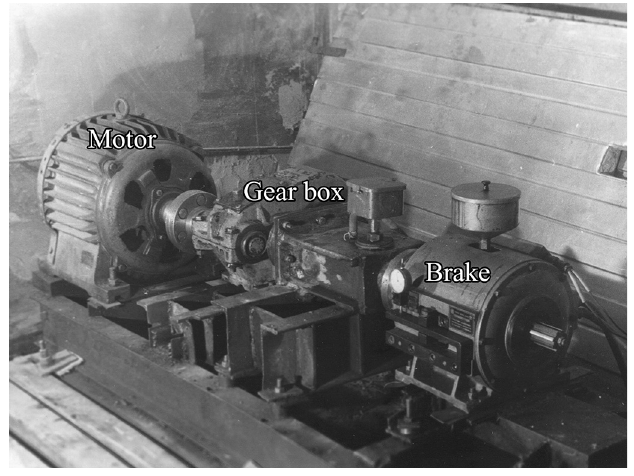
Fig. 6. Gear test rig.